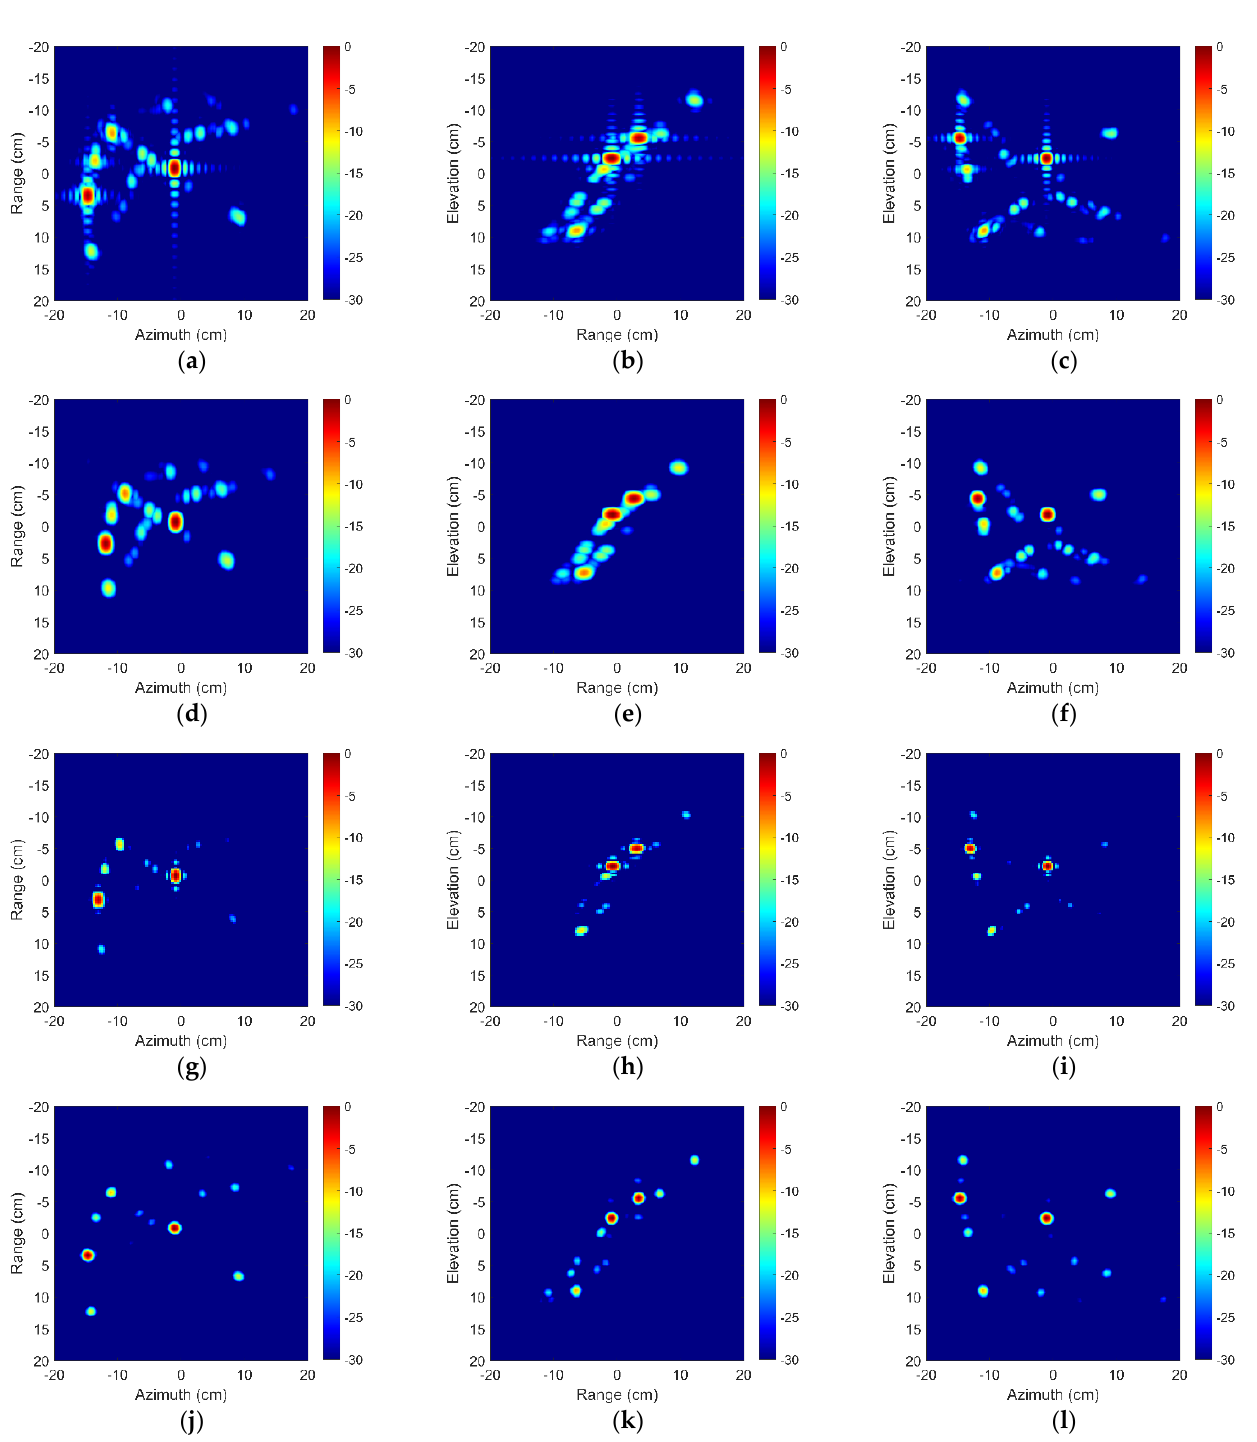
Figure 10. Two-dimension image profiles of aircraft A380 by ( a – c ) 3-D IFFT without windowing, ( d – f ) 3-D IFFT with windowing, ( g – i ) BPDN, ( j – l ) SR-CNN. First column is the range–azimuth profile. Second column is the range–elevation profile. The last column is the azimuth–elevation profile.